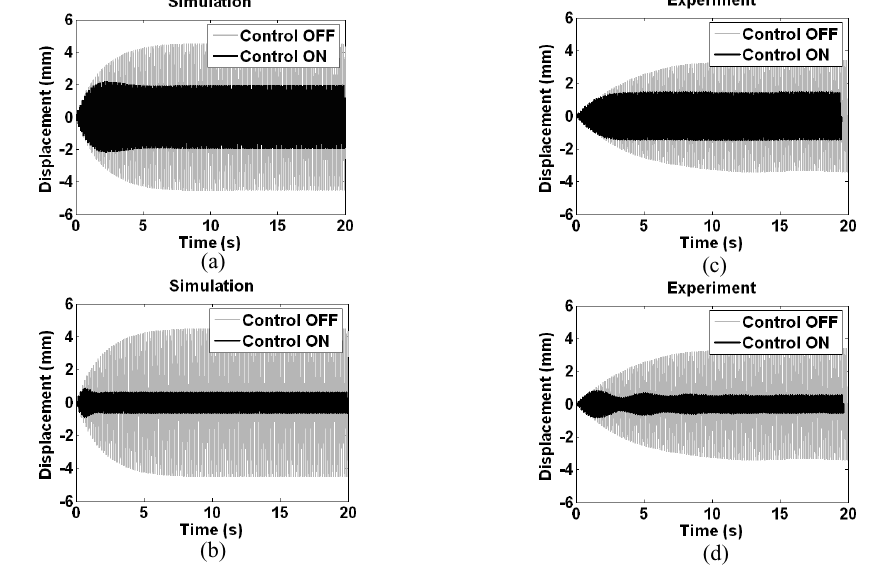
Fig. 13. Case 2 vibration responses for displacement feedback control, simulation for (a) K p = 3.75 and (b) K p = 15, experiment for (c) K p = 3.75 and (d) K p =